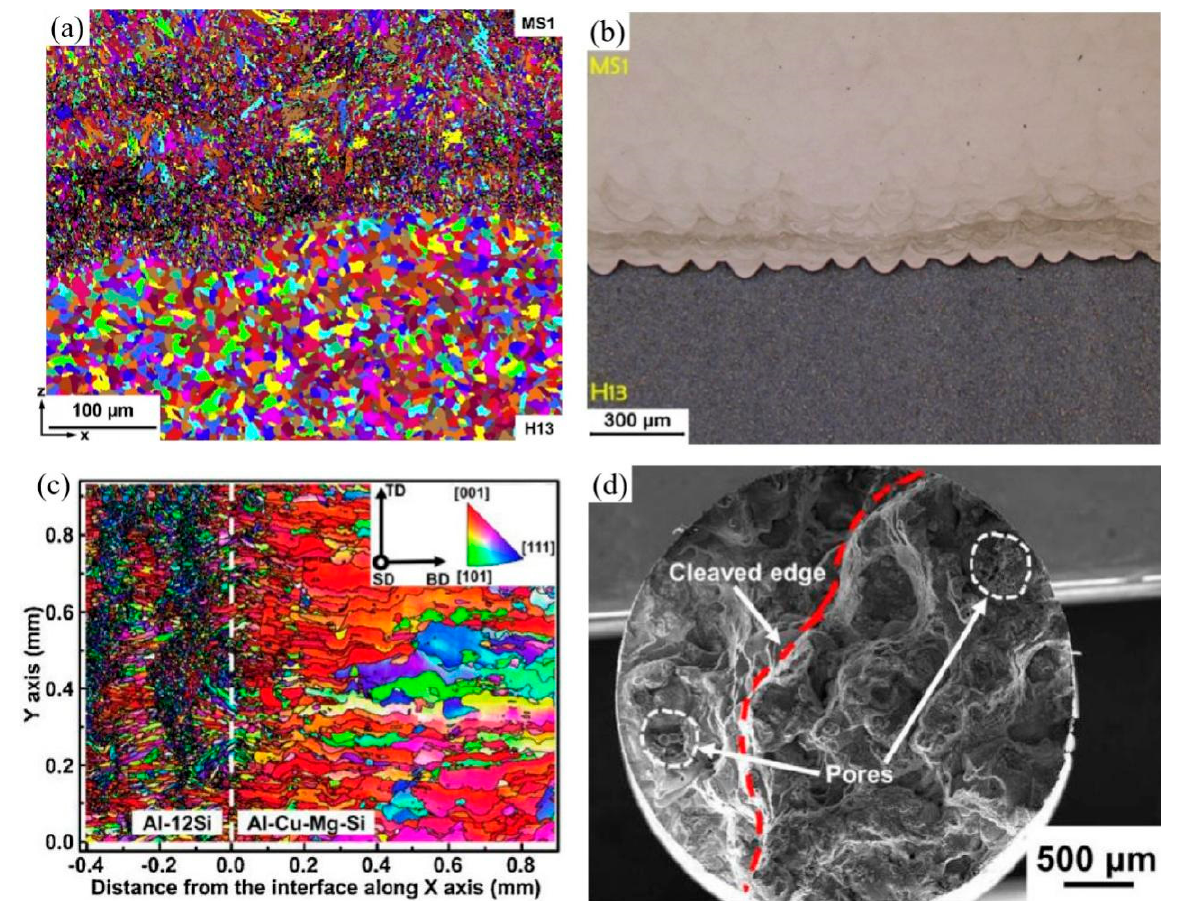
Figure 5. ( a ) Electron backscattered diffraction (EBSD) inverse pole figure (IPF) map; ( b ) Optical micrograph across the interface of the maraging steel–H13 sample [89]; ( c ) IPF of the Al–12Si/Al–3.5Cu interface along the build direction; ( d ) Fracture morphology of the tensile sample [90].